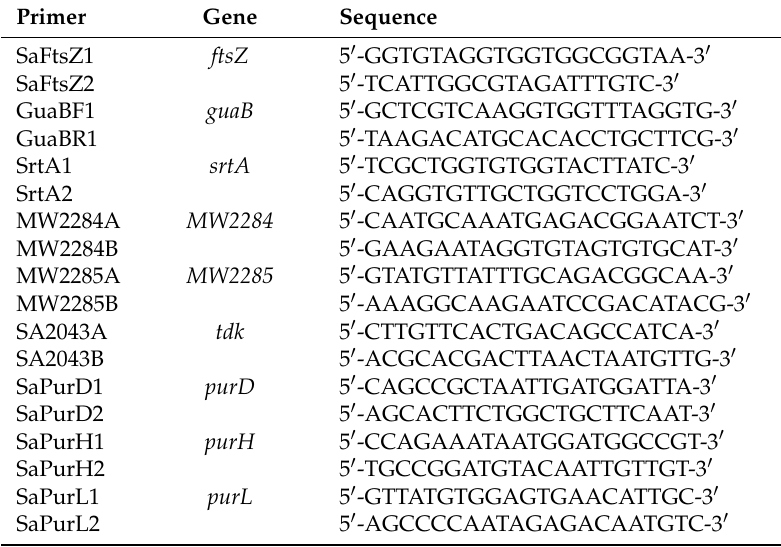
Table 4. Oligonucleotide primers used in this